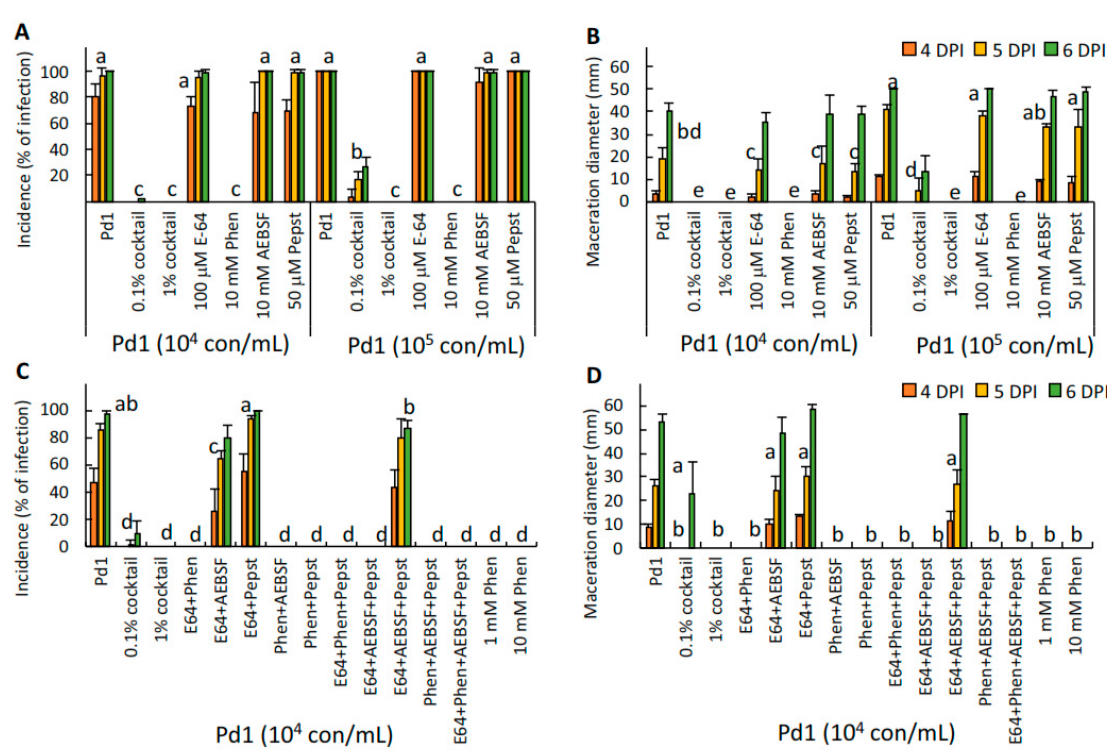
Figure 5. Disease incidence (percentage of infection, A and C ) and severity (maceration diameter, in mm, B and D ) caused by P. digitatum strain Pd1 in artificially inoculated oranges in two independent experiments (experiment 1: A and B ; experiment 2: C and D ) after 4, 5, and 6 days post infection (dpi). Conidia were co-inoculated with the proteinase inhibitors in a final volume of 10 μ L containing the cocktail of proteinase inhibitor cocktail at either 0.1% or 1%, 100 μ M E-64, 1 or 10 mM 1,10-phenanthroline (Phen), 10 mM 4-(2-Aminoethyl)benzenesulfonyl fluoride hydrochloride (AEBSF), or 50 μ M pepstatin A (Pep). Means with the same letter are not significantly different ( p < 0.05) at 5 dpi according to Tukey’s test.